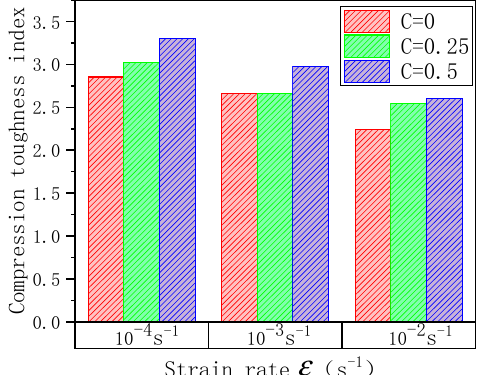
Figure 14. Compressive toughness index of specimens under different lateral pressure levels at different strain rates.